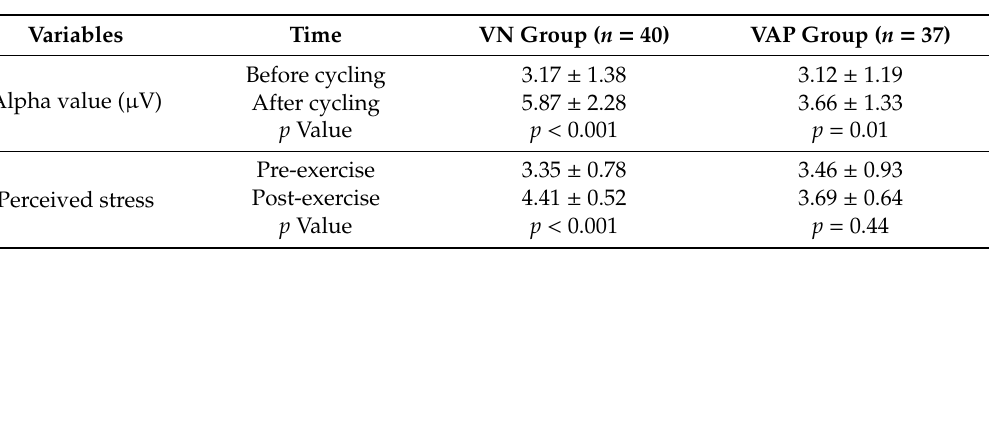
Table 2. Comparisons of alpha value and perceived stress between the VN group and the VAP